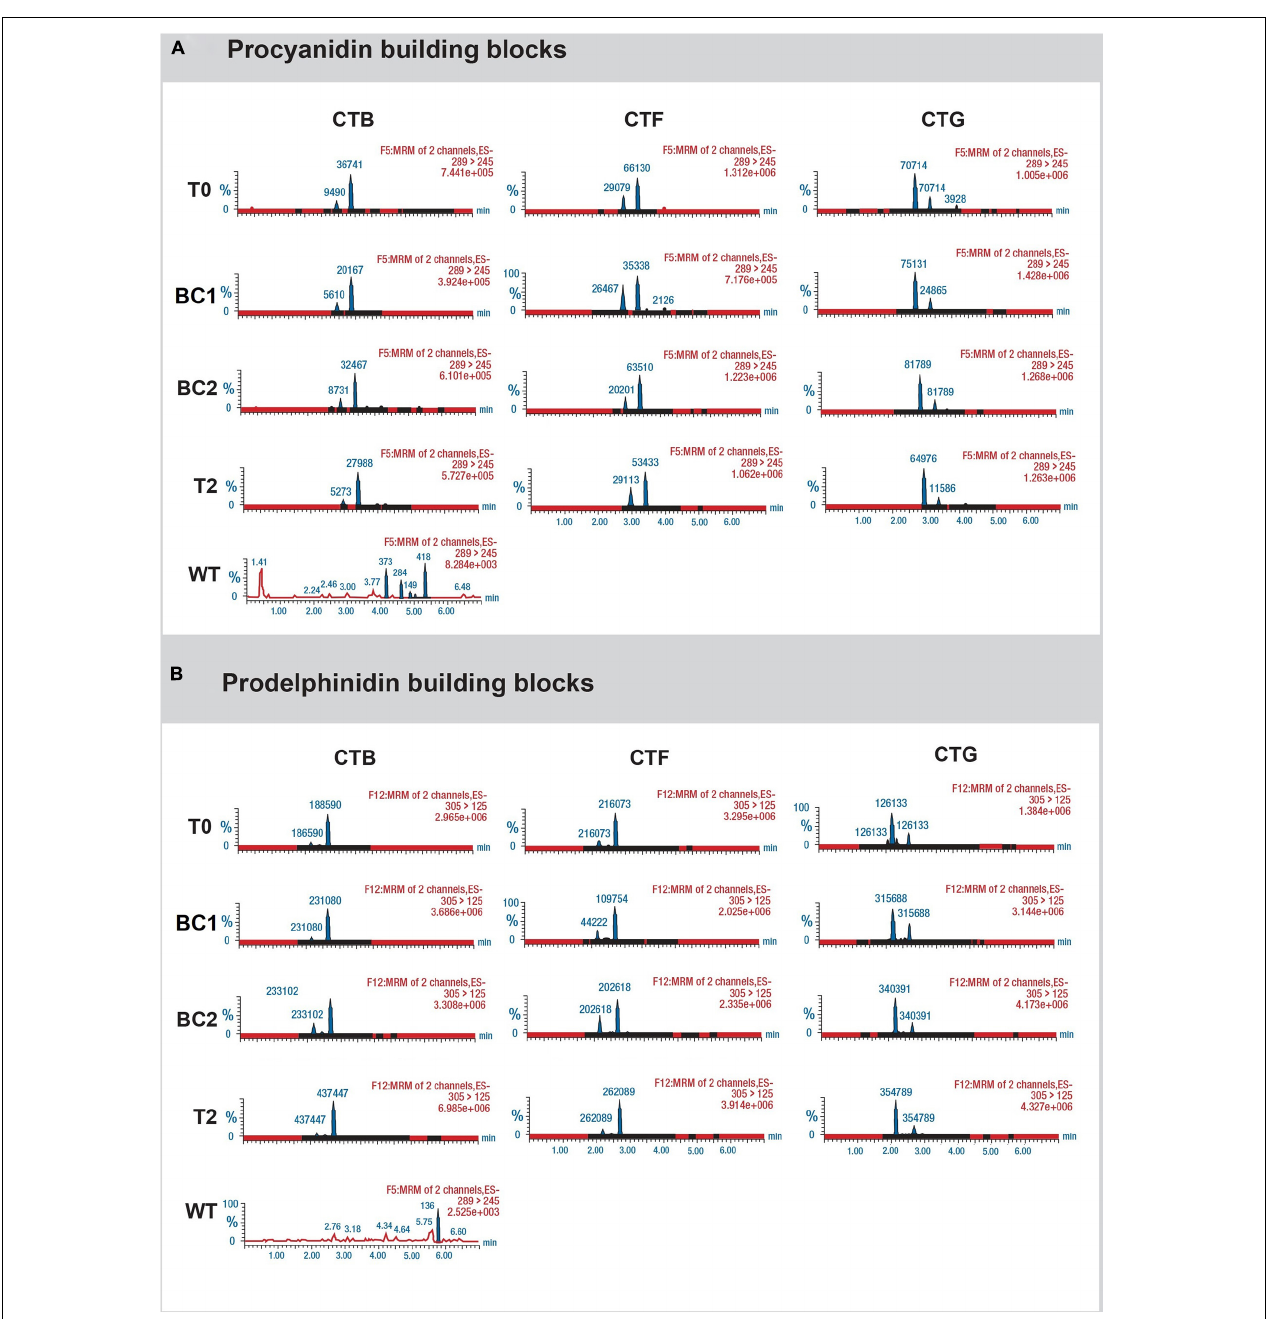
FIGURE 6 | Chromatograms showing (A) the presence of catechin and epicatechin (the monomeric PC building blocks), and (B) gallocatechin and epigallocatechin (the monomeric PD building blocks) from representative progeny from each generation of the 3 white clover transformation events CTB, CTF, and CTG. Analysis was conducted using the Waters triple quadrupole UPLC-DAD-MS/MS system. For wild-type (WT) samples, the levels were negligible.